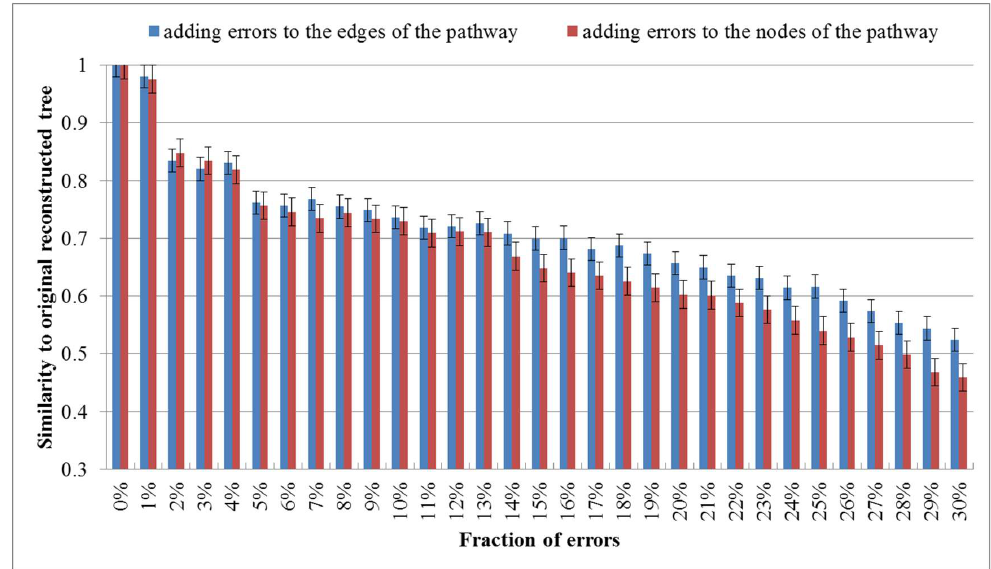
Figure 4. Average values of similarities between perturbed trees and the original one. The error rate increases from 0% to 30%.